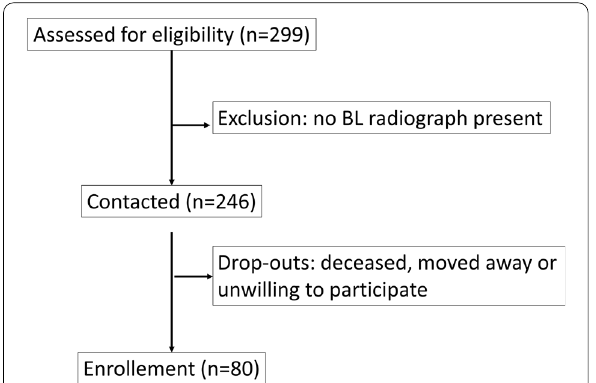
Fig. 1 Flowchart of the study enrollment